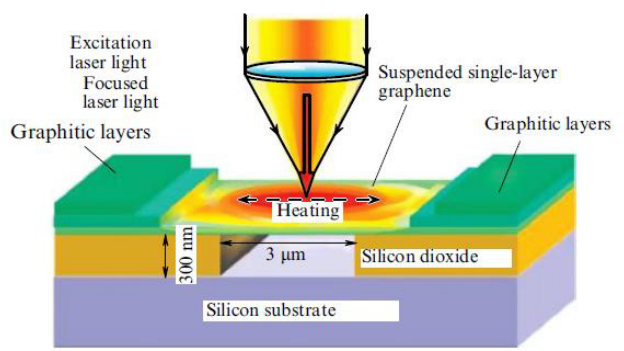
Figure 4. Schematic of the experimental setup for measuring the thermal conductivity of graphene [52,53].